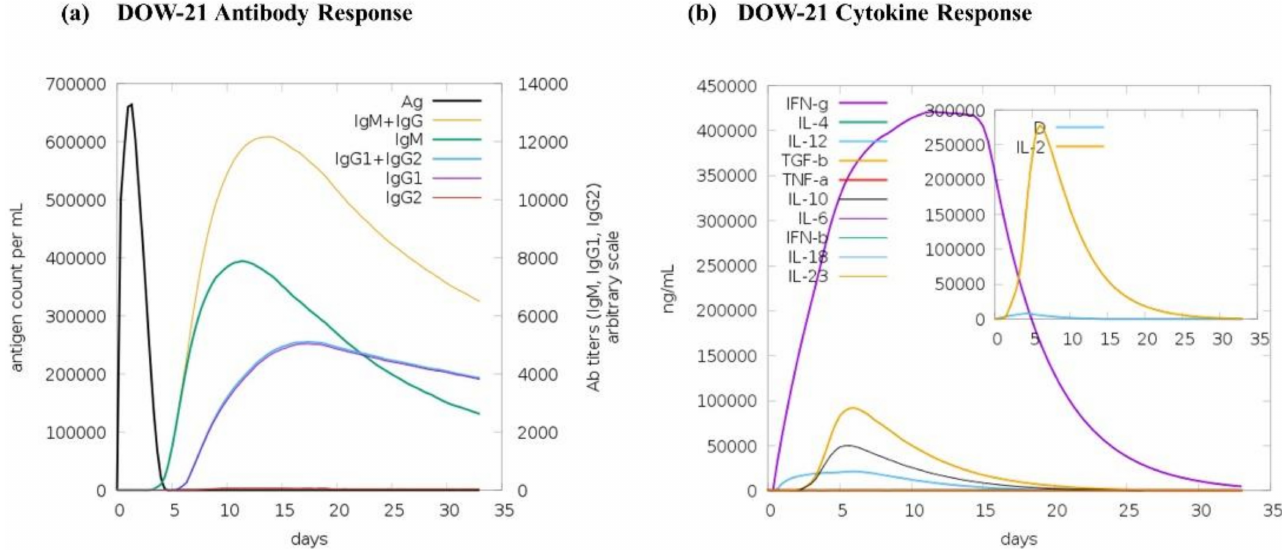
Figure 5. Immune simulation of DOW-21. Predicted immune response for ( a ) antibodies and ( b ) cytokines along with danger signal (inset) of